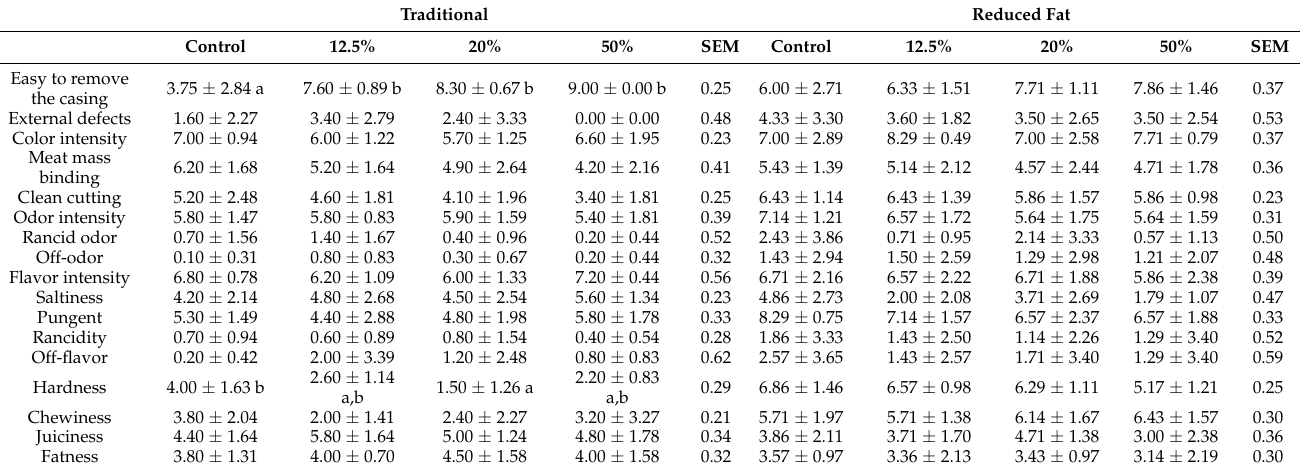
Table 5. Mean values, standard deviation, and standard error of the mean (SEM) of sensory parame- ters for the traditional and reduced fat “Chorizo Zamorano” formulations at the end of ripening.